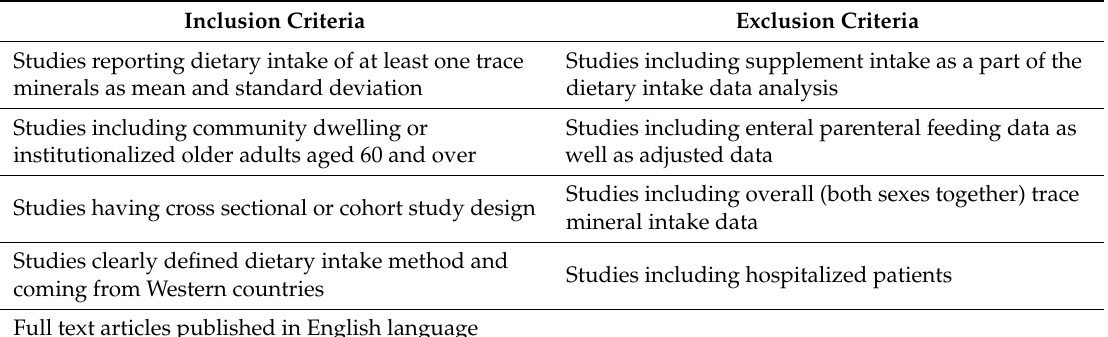
Table 1. Summary of the inclusion and exclusion